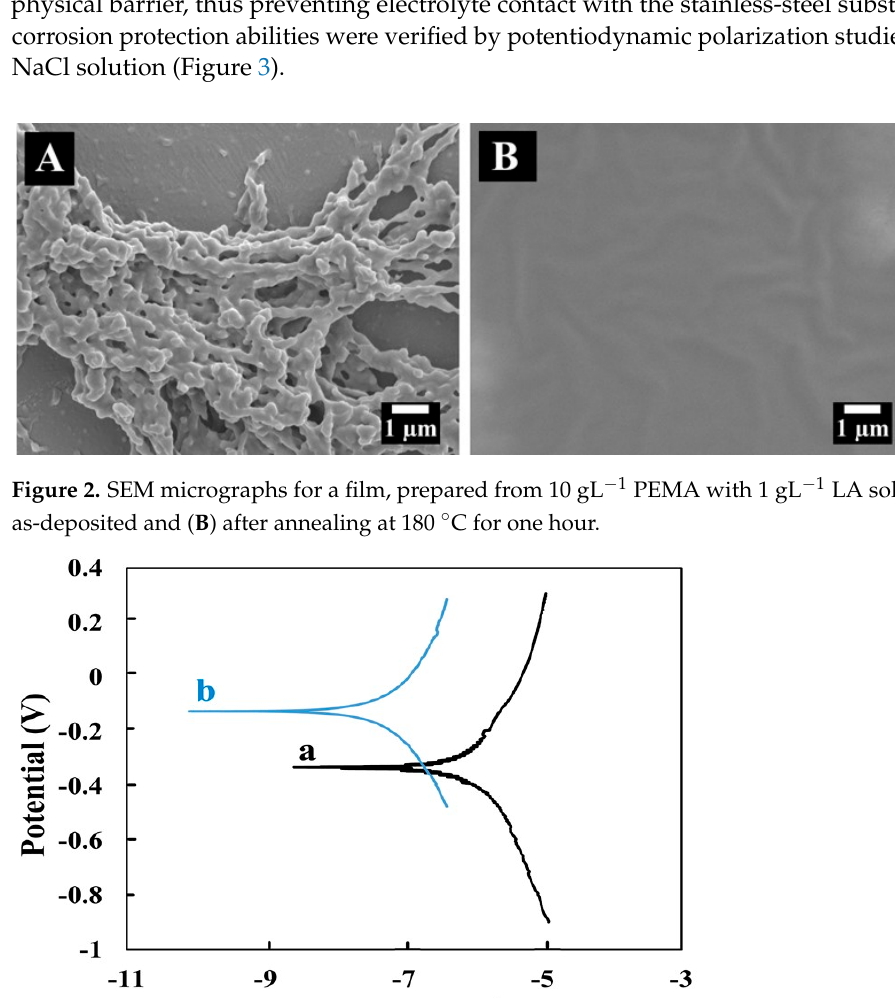
Figure 3. Tafel plots for (a) uncoated and (b) coated stainless steel sample prepared from a 10 gL − 1 PEMA solution containing 1 gL − 1 LA in ethanol and annealed at 180 °C for one hour.